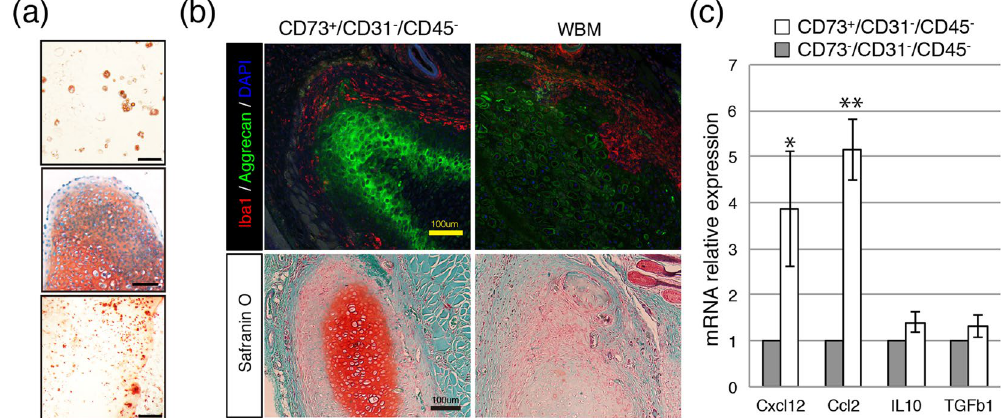
Figure 4. Differentiation ability and lack of infiltration of CD73 + rMSCs. ( a ) Capacity of CD73-MSCs to differentiate into adipocytes, chondrocytes, and osteoblasts. Scale bar, 100 µ m. ( b ) Double fluorescence staining to label the chondrogenic marker aggrecan (green) and the macrophage marker Iba1 (red) (top). Scale bar, 100 µ m. Histological sections of cell pellets transplanted after 2 weeks. The pellets stained with safranin O (low). Scale bar, 100 µ m. ( c ) Quantitative analysis of the mRNA expression of Cxcl12 , Ccl2 , Il10 , and Tgf b1 in freshly isolated MSCs (CD73 + and CD73 − cells). The mRNA expression of each gene was normalized to that of Hprt. The gene expression in CD73 − CD45 − CD31 − cells was set as